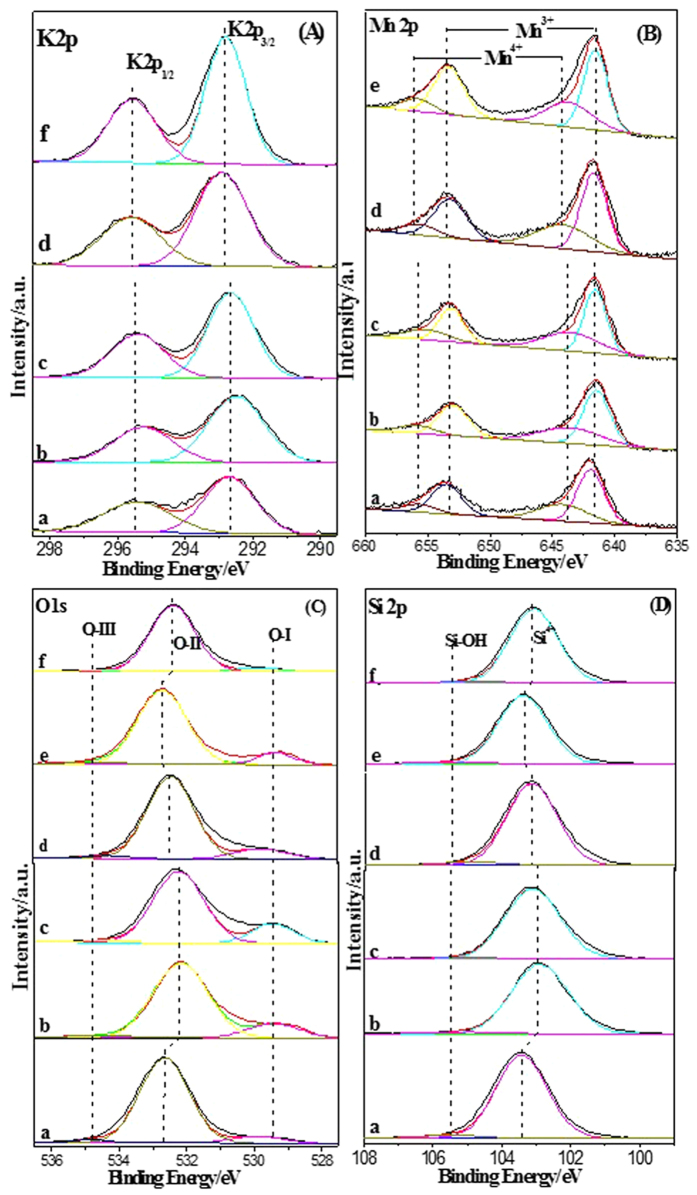
K 2p (A), Mn 2p (B), O1s (C) and Si 2p (D) XPS spectra of as-prepared catalysts (K-OMS-2/SiO2-20 (a), K-OMS-2/SiO2-50 (b), K-OMS-2/SiO2-70 (c), K-OMS-2/silica gel-50 (d), MnOx/SiO2-50 (e) and KNO3/SiO2-50 (f)).